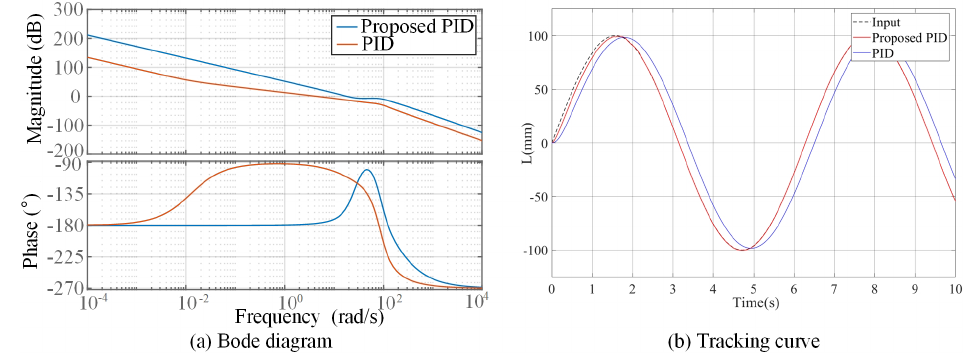
Figure 17. Proposed controller compared with traditional PID Bode diagram and sinusoidal tracking curve.